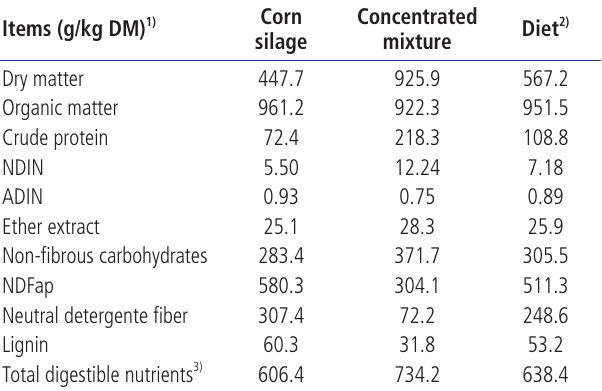
Table 1. Chemical composition of ingredients and diet used during experimental period Items (g/kg DM)